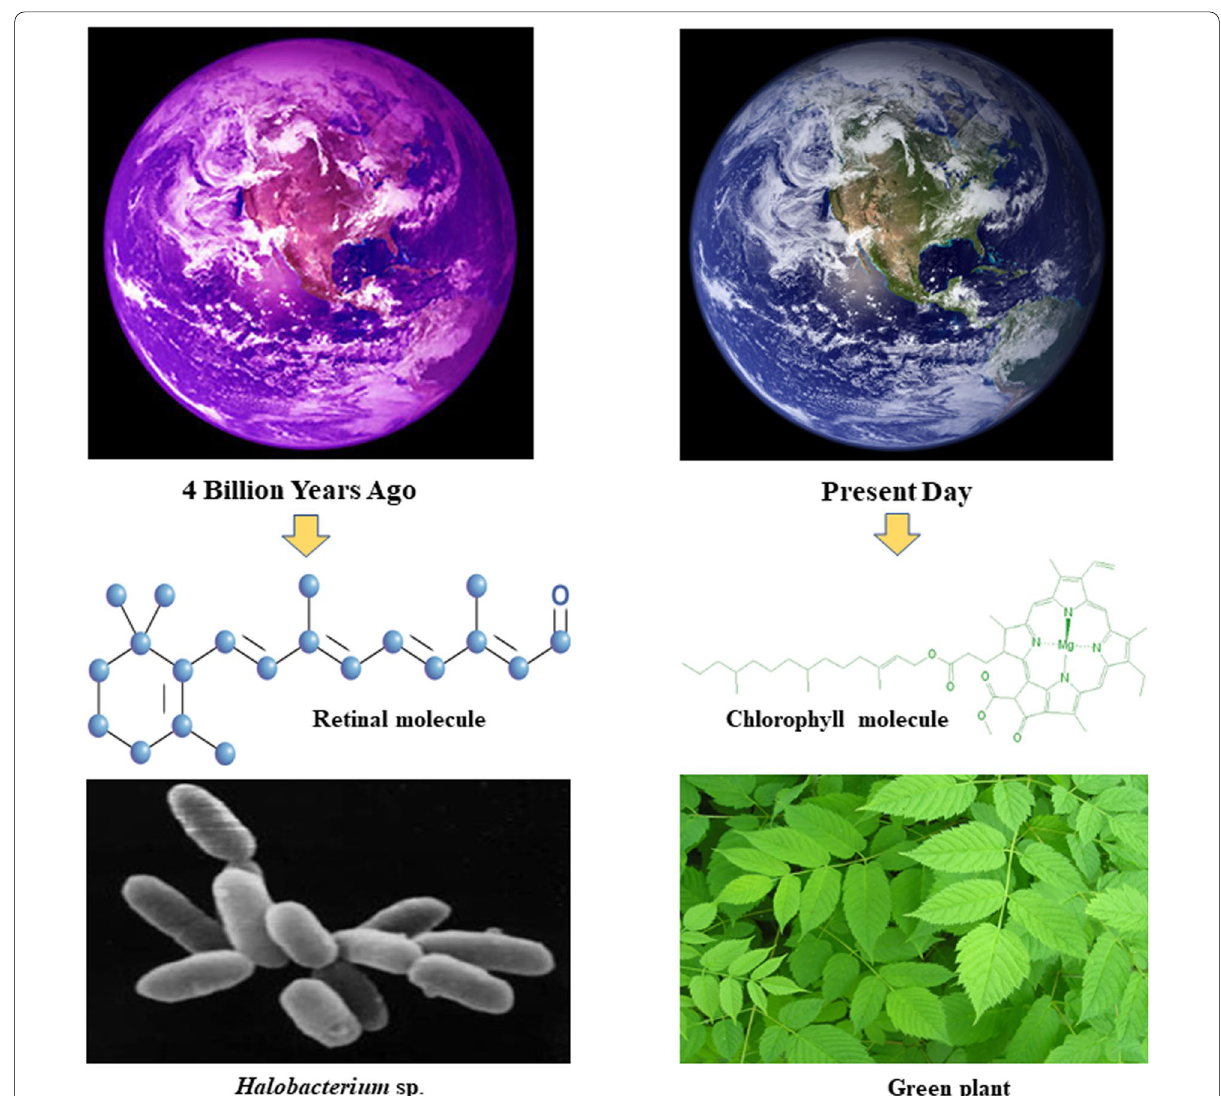
Fig. 3 Evolution of purple earth to today’s green vegetation [the composite picture was made by using following sources: Halobacetrium NRC-1-https:// en. wikip edia. org/ wiki/ Halob acter ium; Purple earth-DasSarma and Schwieterman (2019); Satellite Images of the Whole Earth ‑ NOAA’s Geostationary Operational Environmental Satellites release